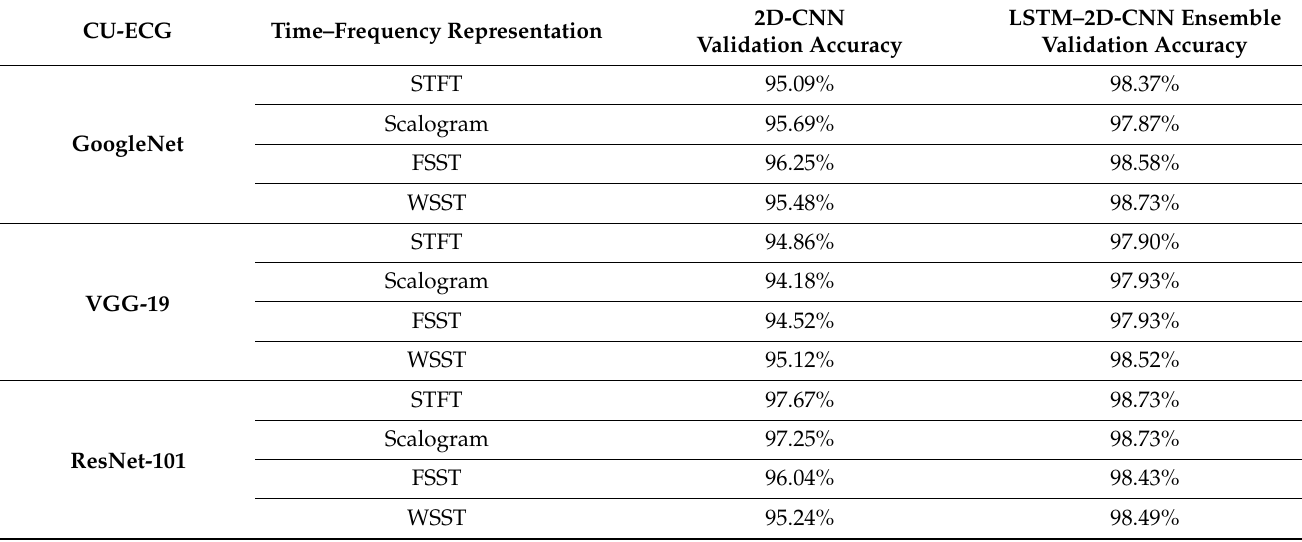
Table 1. Accuracy of LSTM and 2D-CNN-based